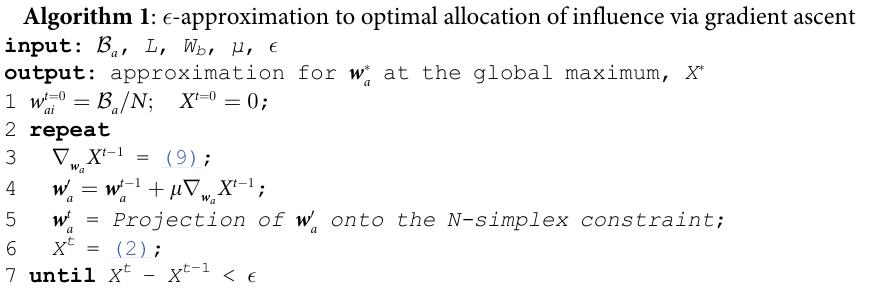
Algorithm 1 : � -approximation to optimal allocation of influence via gradient